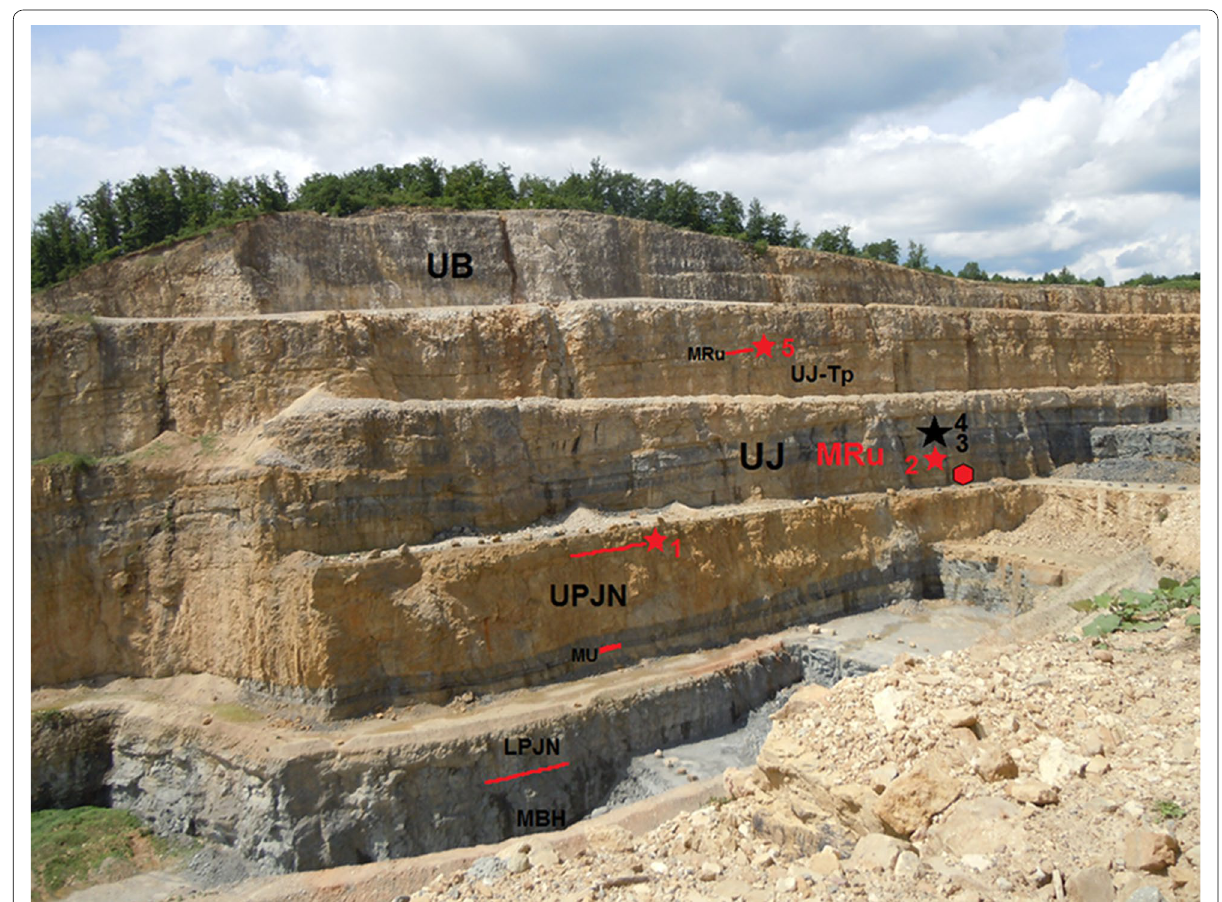
Fig. 2 Western part of the Eclépens quarry (17/6/2018). Captions: UB Urgonien Blanc, MRu Marnes de la Russille, UJ‑Tp Urgonien Jaune = = = top part, UJ Urgonien Jaune, UPJN Upper Pierre jaune de Neuchâtel, MU Marnes d’Uttins (late Early Hauterivian Nodosoplicatum Zone), = = = LPJN Lower Pierre jaune de Neuchâtel, MBH Marnes bleues d’Hauterive (Early Hauterivian Radiatus Zone), black star marly beds with early Late = = = Barremian nannofloras reported from Godet et al. (2010), red hexagon basal limestones with glauconite and early Late Hauterivian ammonite = Cruasiceras cf. cruasense , red stars marls with new Early Barremian (1–2) and early Late Barremian (3–5) =